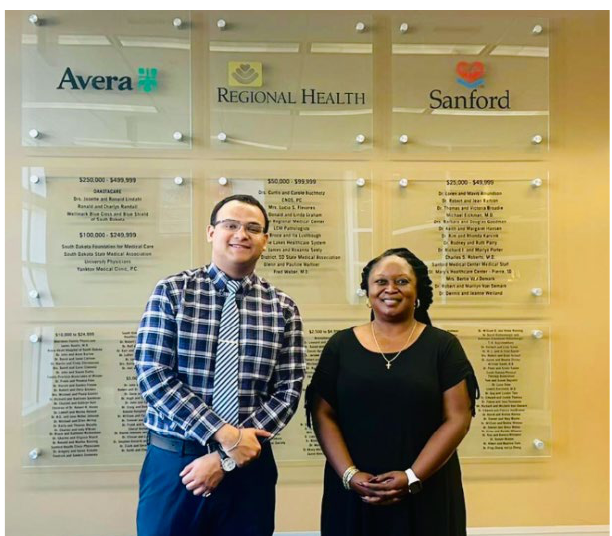
Figure 1 . Ahmed Nahian, Recipient of the Summer Program